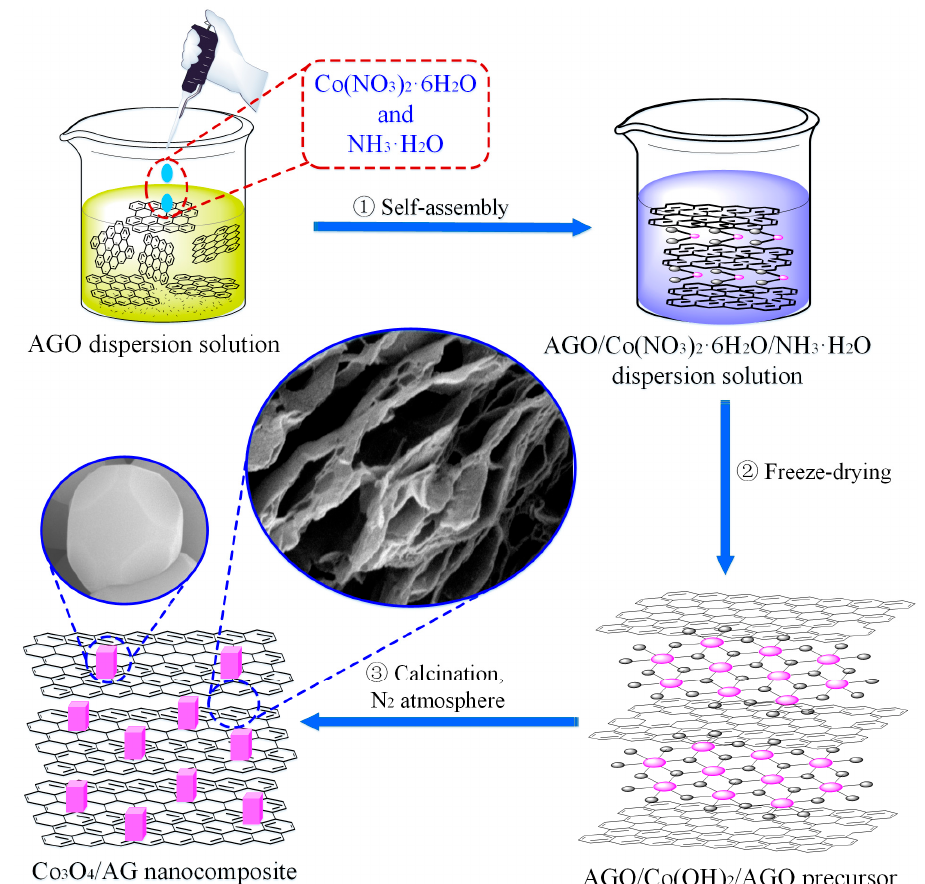
Figure 1. Schematic illustration of the synthetic process of the Co 3 O 4 /AG